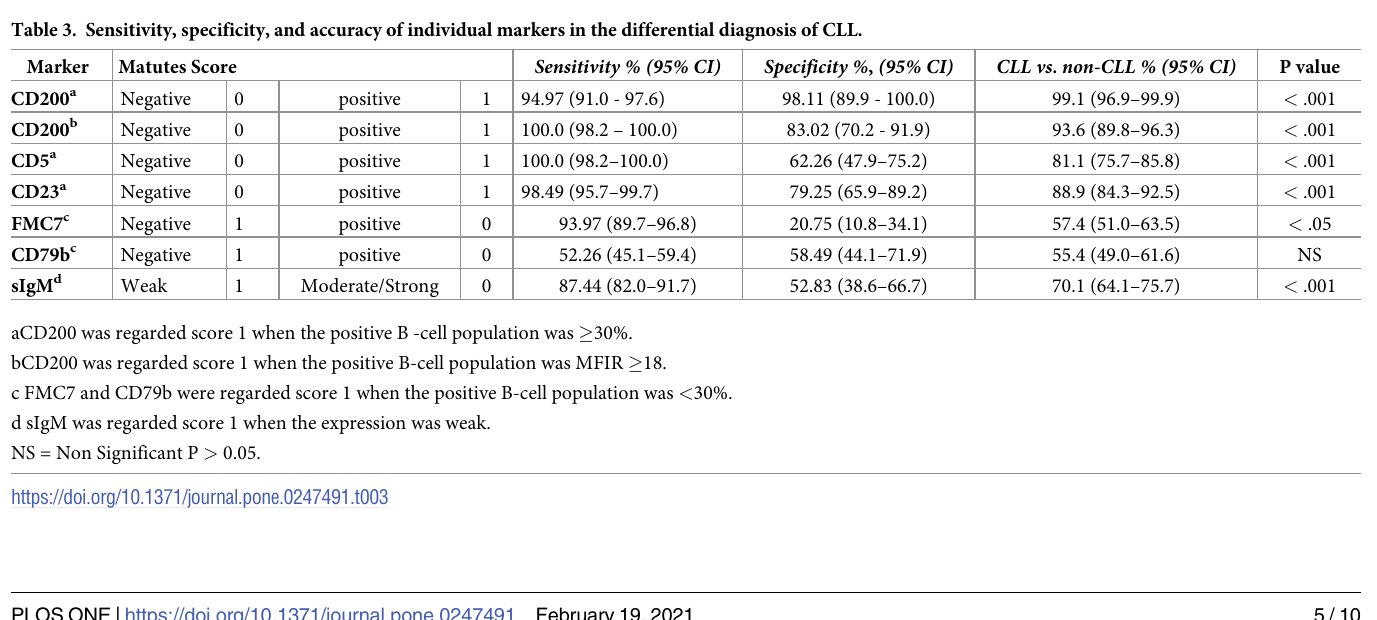
199 CLL cases displayed a potentially higher MFIR of CD200 expression [median MFIR of 59